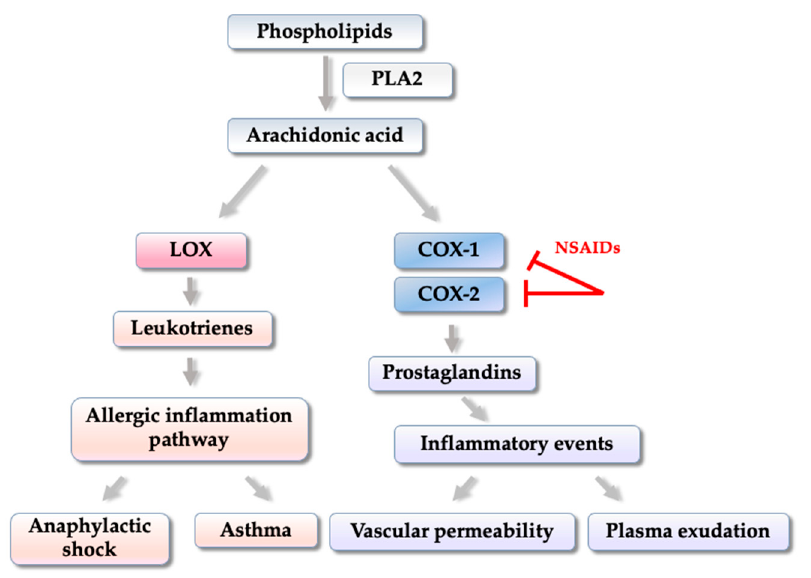
Figure 2. Simplified diagram of COX-1, COX-2 and LOX enzymes activation and beginning of the inflammatory process.